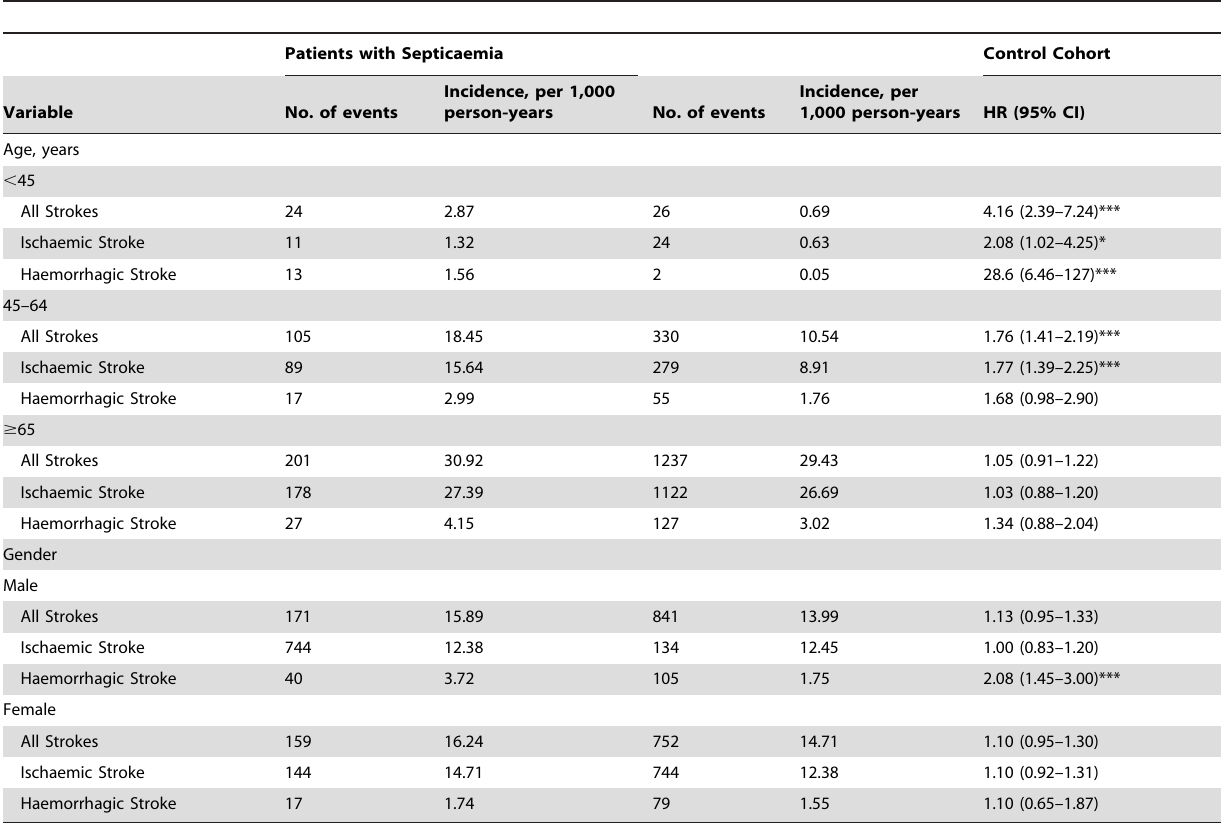
Table 3. Hazard ratios for the development of stroke associated with septicaemia by age and